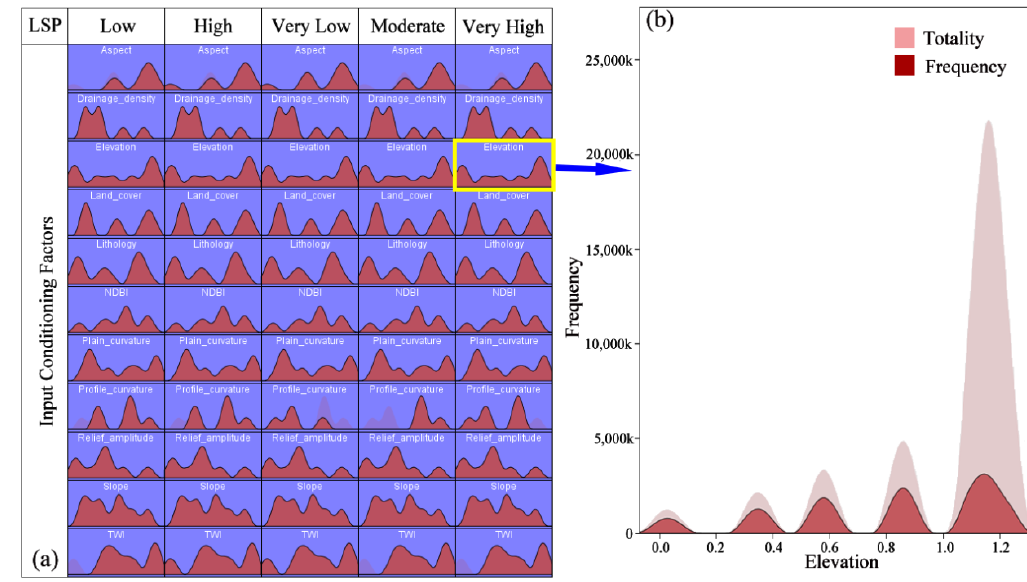
Figure 9. The distribution of conditioning factors for each LSP class of Kohonen model.